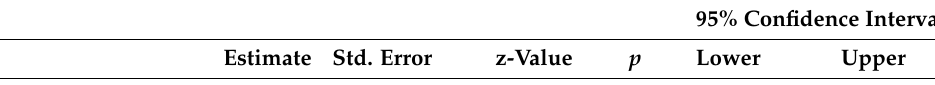
Figure 3. Mediation Analysis. Note: CPA—Positive attitude; DSS—Decentering Sport Scale; CPS—